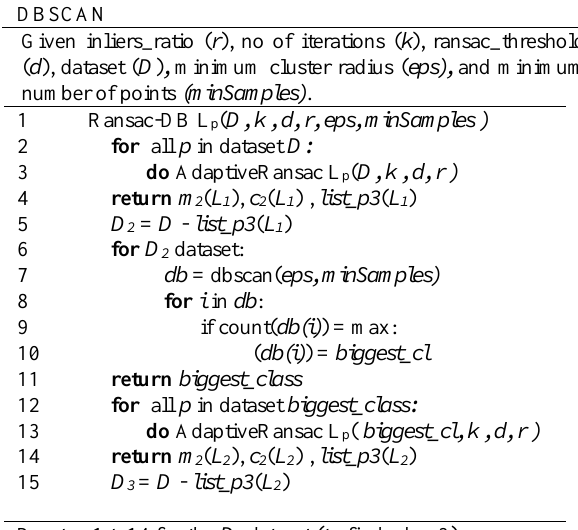
Figure 6. Line extraction from combined RanSAC – DBSCAN 3.4 DSM and true orthophotos generation The extracted building lines are then reprojected into 3D lines by interpolation using the original LiDAR DSM. These 3D lines are then used as hard breaklines for DSM optimization. The breaklines are expected to represent surface discontinuities and enhance the height jump at building roof edges. Figure 7. shows the difference of a DSM without breaklines (left image) and an optimized DSM with breaklines (right image). The building edge in the right image has indeed more straight representation.